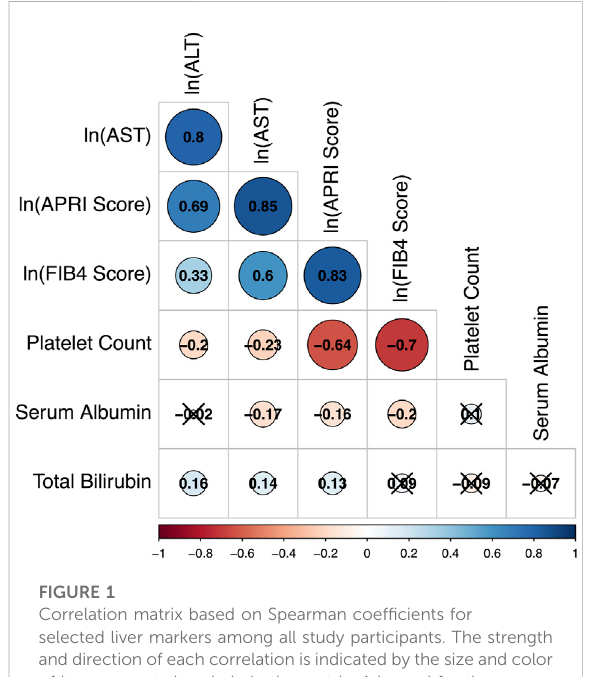
FIGURE 1 Correlation matrix based on Spearman coef fi cients for selected liver markers among all study participants. The strength and direction of each correlation is indicated by the size and color of its representative circle in the matrix. A legend for the colors is included beneath the matrix. Values of the Spearman correlation coef fi cients are also presented within the circles. Cross-off circles indicate that the observed correlation coef fi cient is not statistically signi fi cant after Bonferroni correction to an overall a =